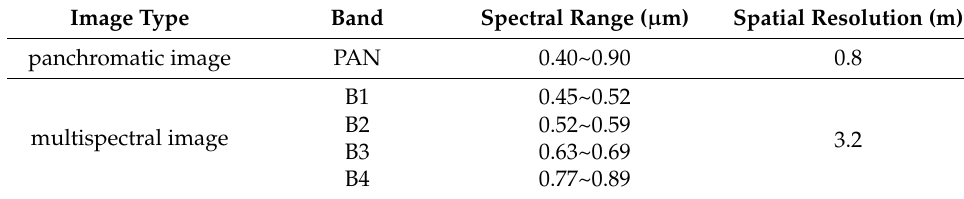
Table 2. GF-2 satellite image